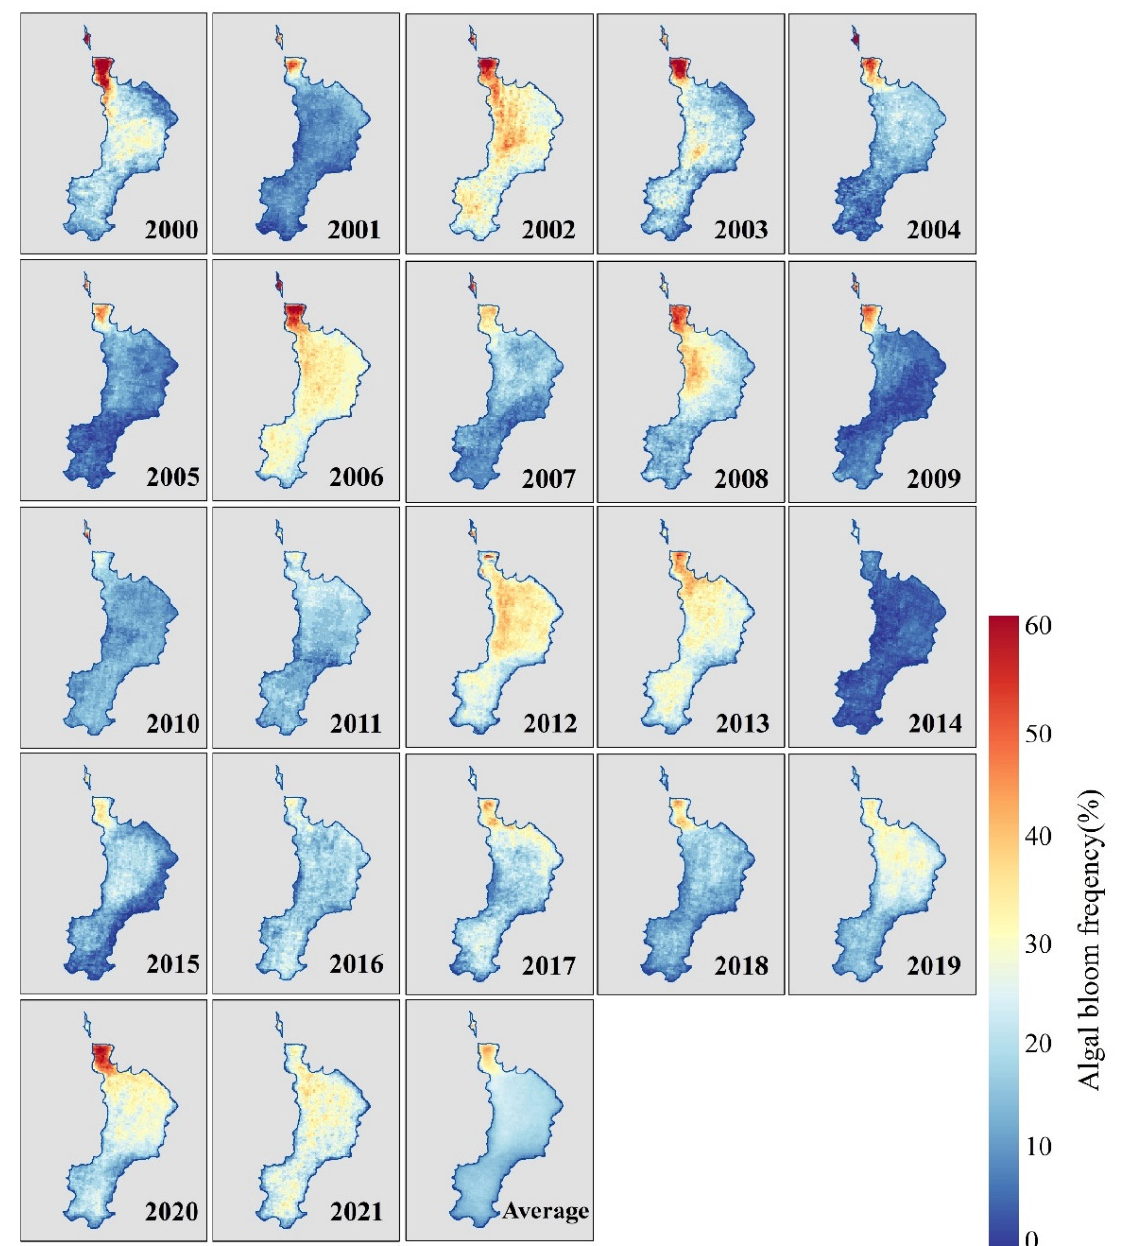
Figure 6. Annual bloom frequency distributions derived from MODIS/Terra imagery (2000 − 2021) for Lake Dianchi in China.